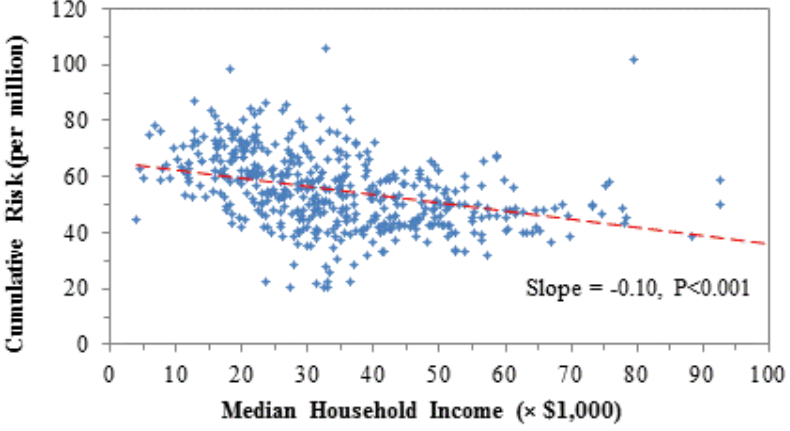
Figure A2. Relationship between the cumulative risk from all toxics and household income.